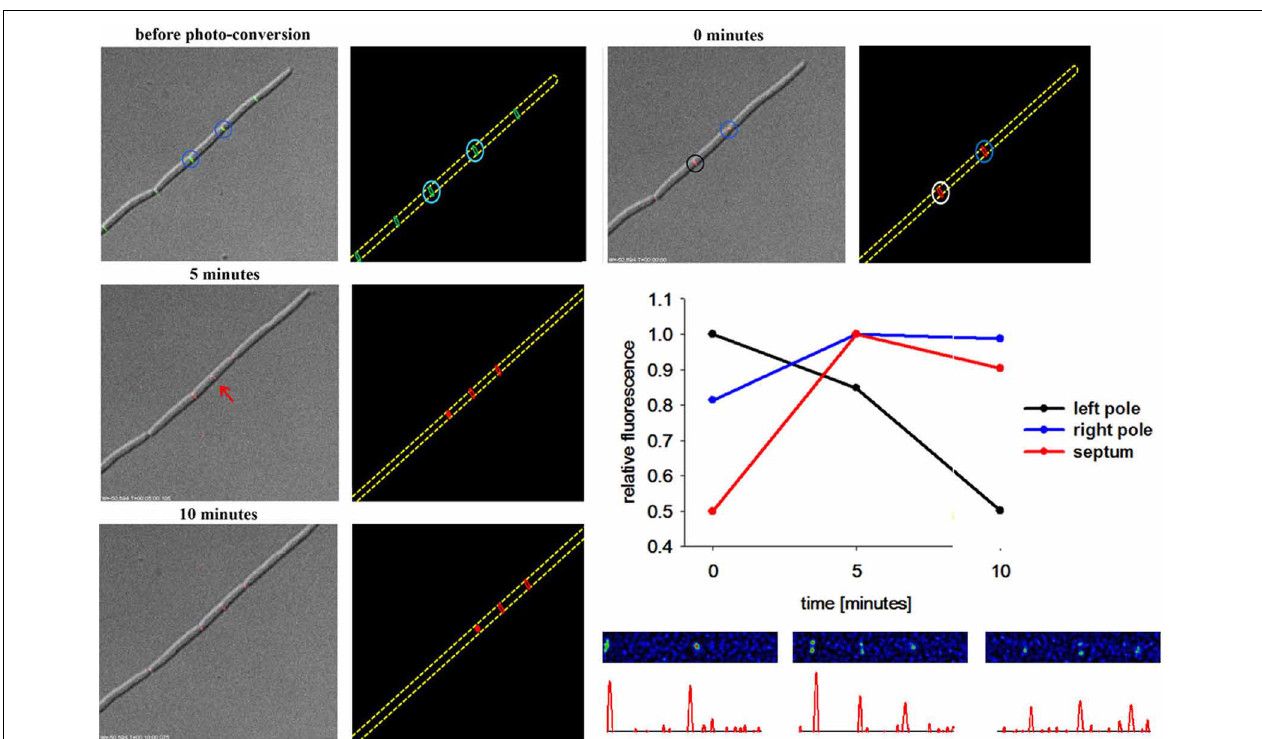
FIGURE 4 | DivIVA-Dendra2 is dynamically recruited from the cell pole to the septa. DivIVA-Dendra2 fluorescence (green and red) was imaged before photoconversion using DIC, FITC, or TRITC specific filters. After photoconversion using a 405nm laser (cyan circles) only red fluorescence (TRITC) and DIC was monitored to prevent additional photoconversion. After 5min DivIVA-Dendra2 is recruited from the place of photoconversion (black and blue circle) to new septa forming (red